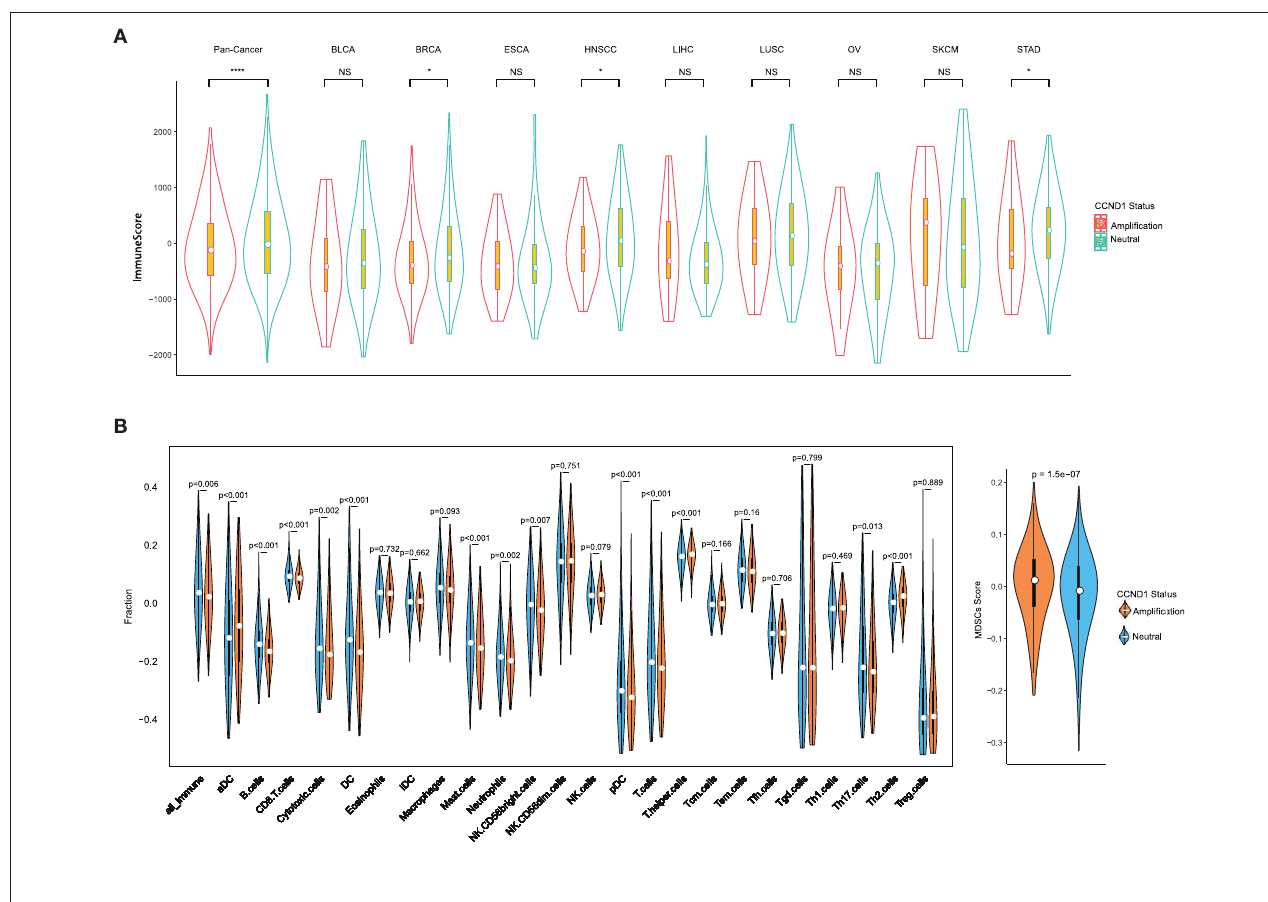
FIGURE 3 | Tumor purity estimate and infiltration levels of immune cells in The Cancer Genome Atlas (TCGA) pan-cancer cohort. (A) The ESTIMATE (Estimation of STromal and Immune cells in MAlignant Tumor tissues using Expression data) score of cancers between the cyclin D1 (CCND1) amplification group and the neutral group in TCGA pan-cancer cohort ( n = 2,633). The white dot represents the median value. The bottom and top of the violins are the 25th and 75th percentiles (interquartile range). Differences between the two groups were evaluated by unpaired t -tests. ns P ≥ 0.05; * P < 0.05; ** P < 1 × 10 − 2 ; *** P < 1 × 10 − 3 ; **** P < 1 × 10 − 4 . (B) The measurement of the infiltration levels of 25 immune cell populations between the CCND1 amplification group and the neutral group in the TCGA pan-cancer cohort ( n = 2,633). The median white dot represents the median value, while the upper and lower represent the minimum and maximum values. Differences between the two groups were evaluated by unpaired t